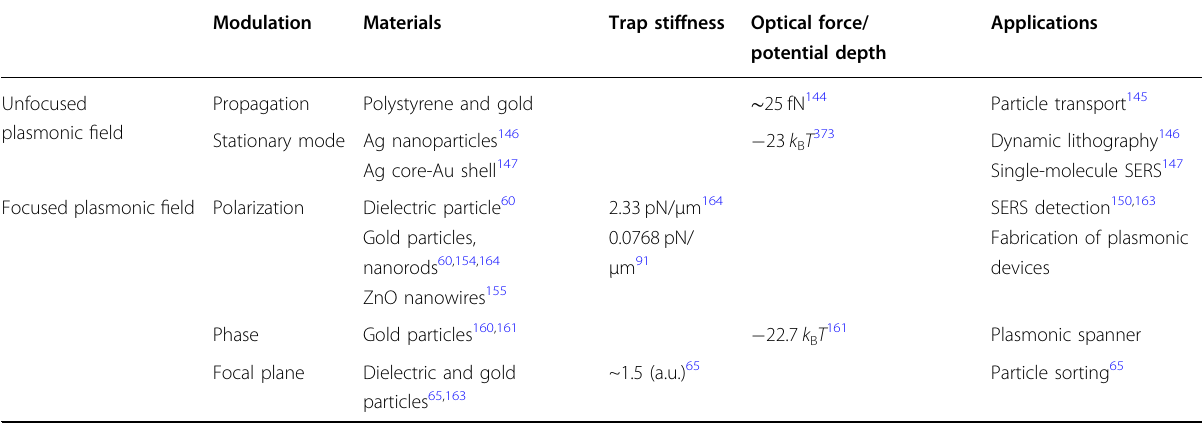
Table 2 Parameters, properties and applications of structureless plasmonic trapping